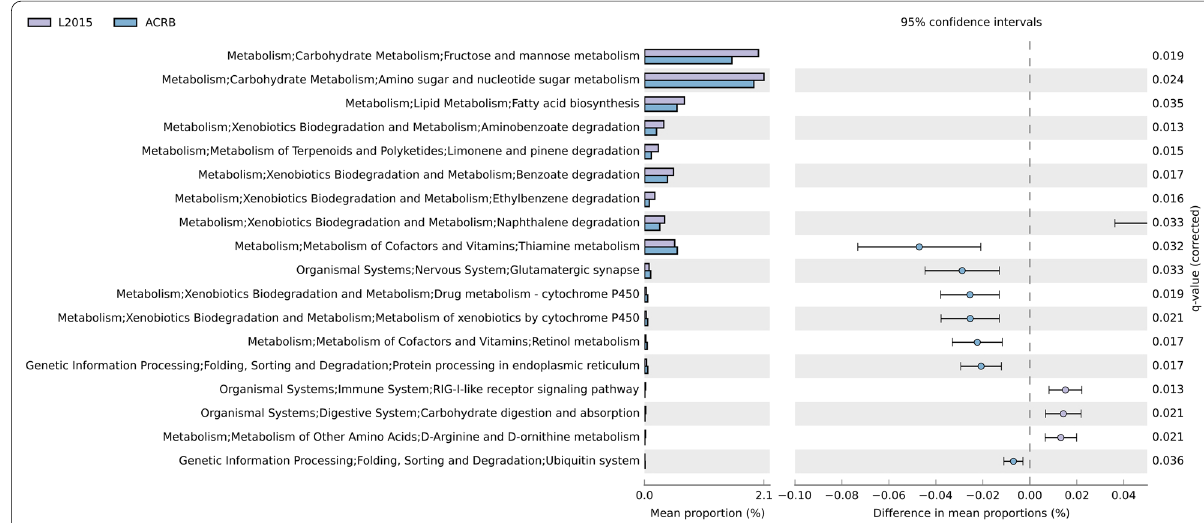
Fig. 6 Predicted functions of ileal content microbiota in modern random bred chickens (L2015) compared to Athens‑Canadian Random bred chickens (ACRB) on d 56. Differentially regulated metabolic pathways are shown. (n